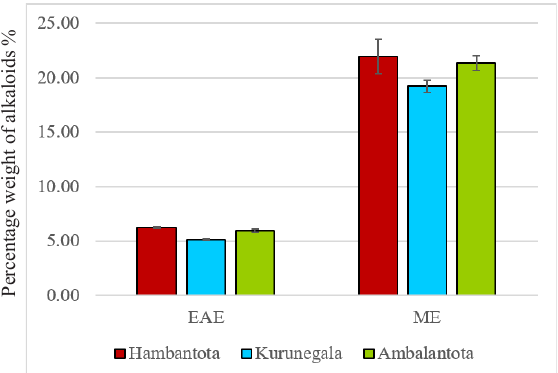
Figure 5: Comparison of alkaloid percentage.